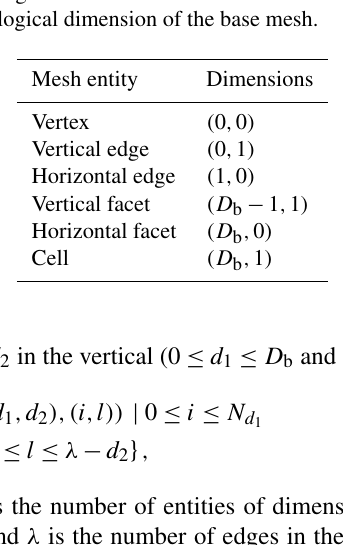
Table 1. Topological dimensions of extruded mesh entities. D b de- notes the topological dimension of the base